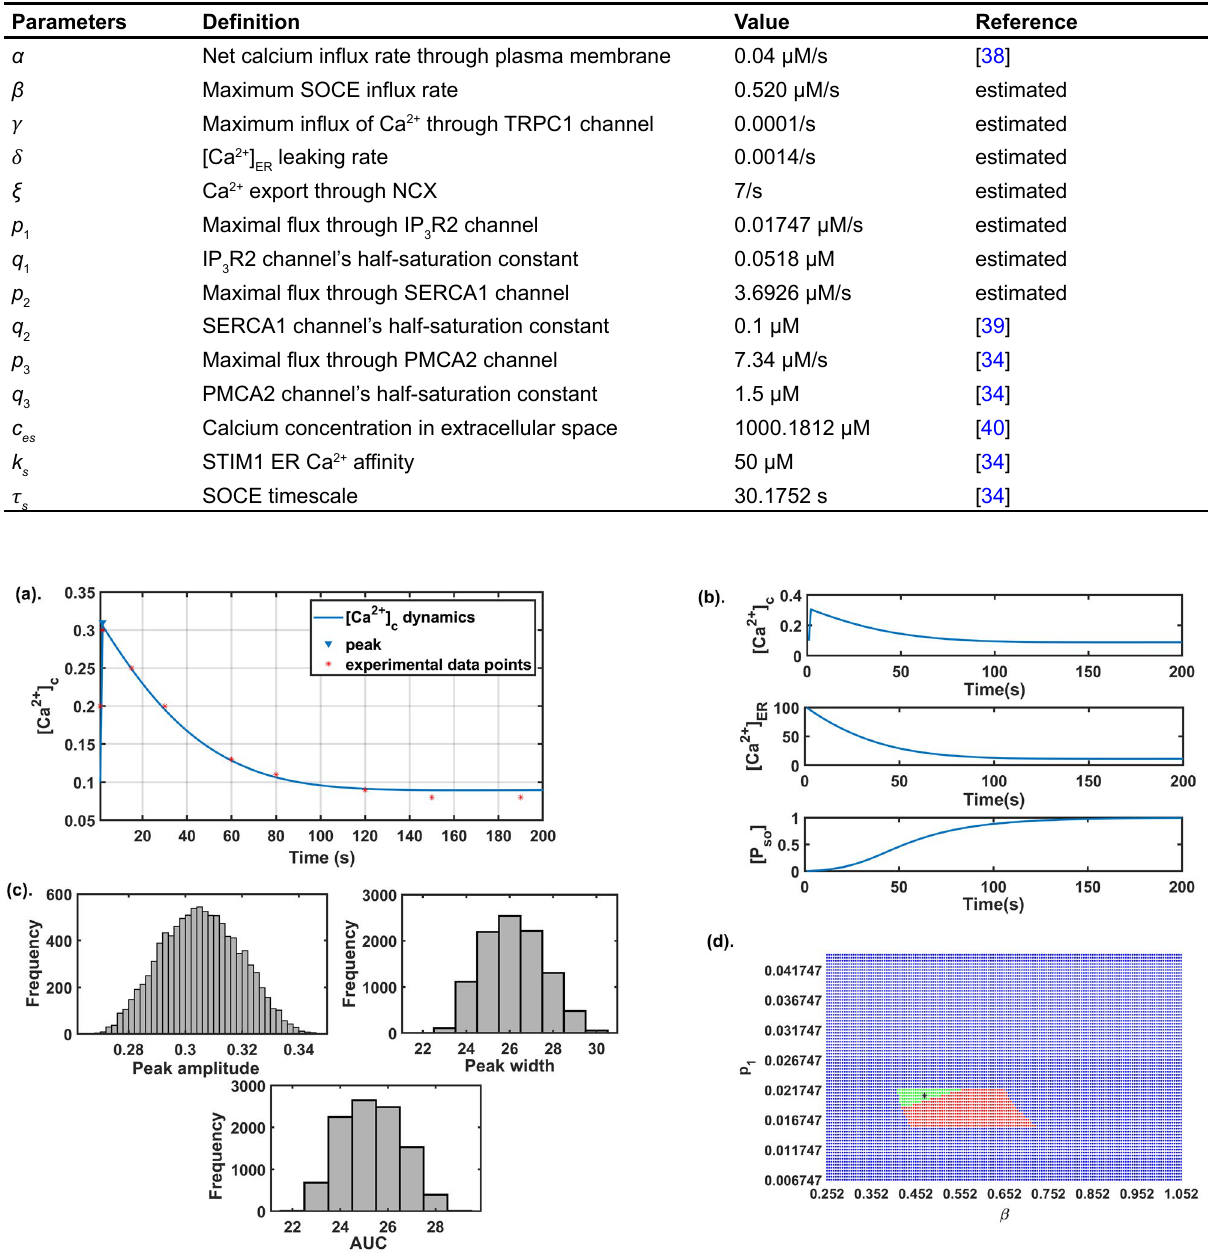
Figure 2. Preliminary analysis: (a) the best fit curve obtained by the least square method for estimation of parameters using experimental data [13]; (b) the dynamics of all state variables of the model for the parameter set given in Table 1; (c) the histogram plots of peak amplitude, peak width, and AUC were obtained on the parametric variation of ± 10% from the baseline; (d) the 2D parameter space between β and p 1. Here, green color represents stable (focus) CRD region, red color represents stable (node) CRD region with negative real eigenvalues and blue color represents non-CRD stable region. The black star mark in the figure represents the baseline value of both